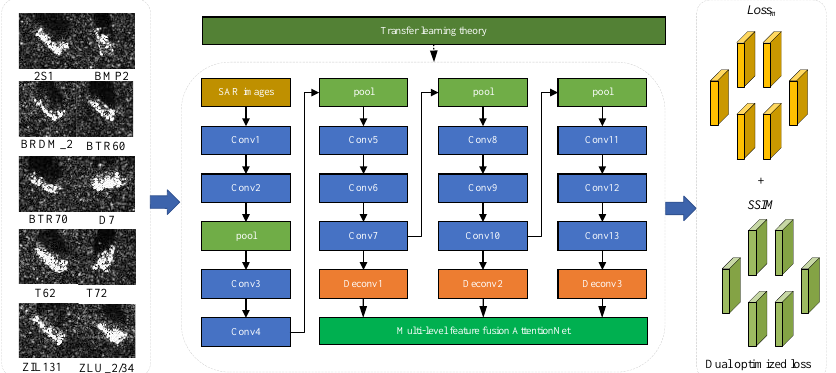
Figure 1. The proposed multi-level feature fusion attention network with dual optimized loss. The diagram of the proposed classification framework can be divided into five parts. Feature